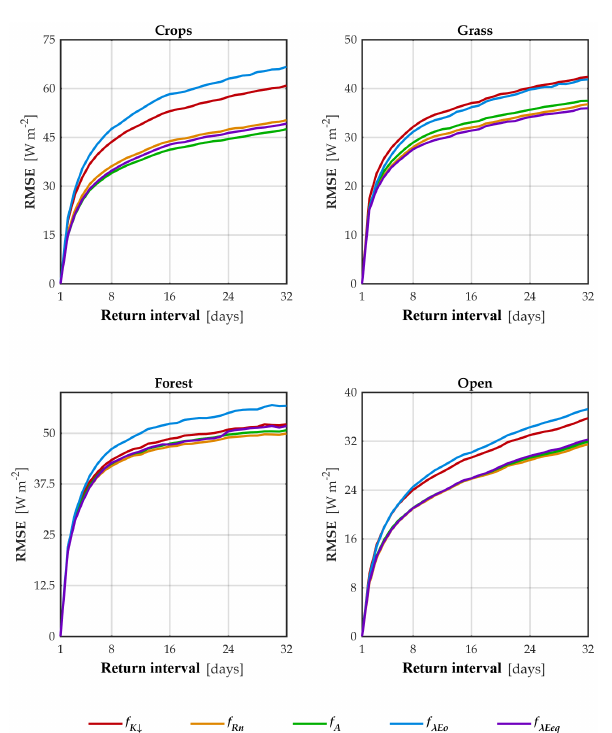
Figure 9. The root mean square error (RMSE) of the latent heat flux derived from each of the scaled quantities is shown for each land cover type when linear interpolation is used.